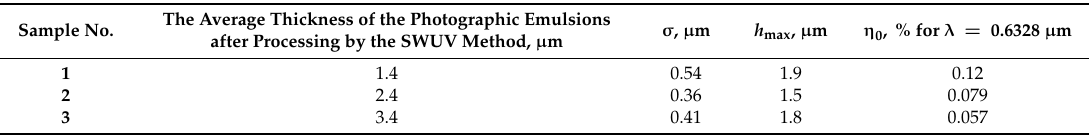
Table 2. Parameters of holographic